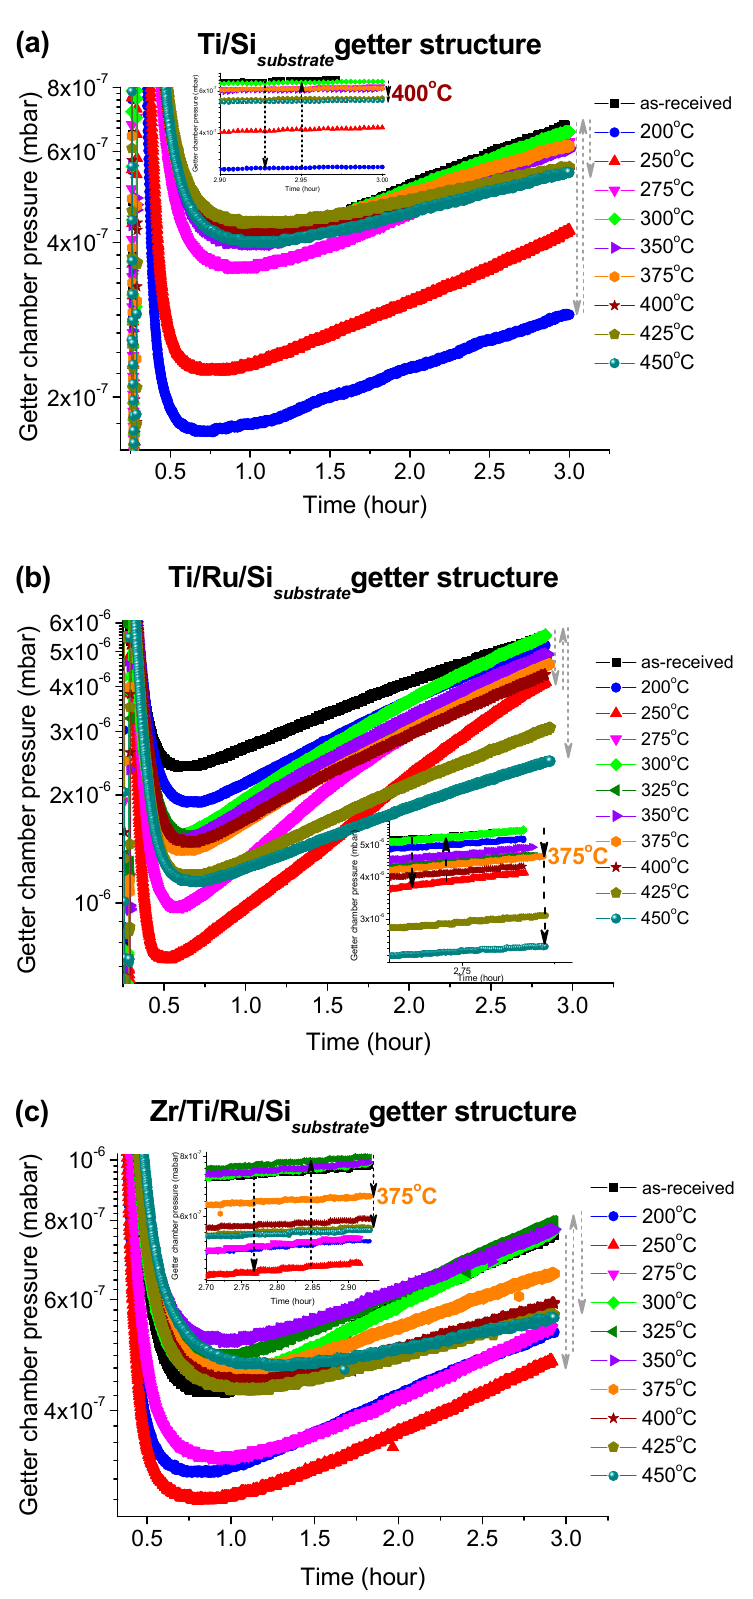
Figure 6. Variation of the getter chamber pressures after different activation temperatures. ( a ) Single layer Ti/Si NEG; ( b ) multilayer Ti/Ru/Si NEG and ( c ) multilayer Zr/Ti/Ru/Si NEG. Insets are detailed views of the magnified zone of pressure evolution in the right side of the P–time curves.